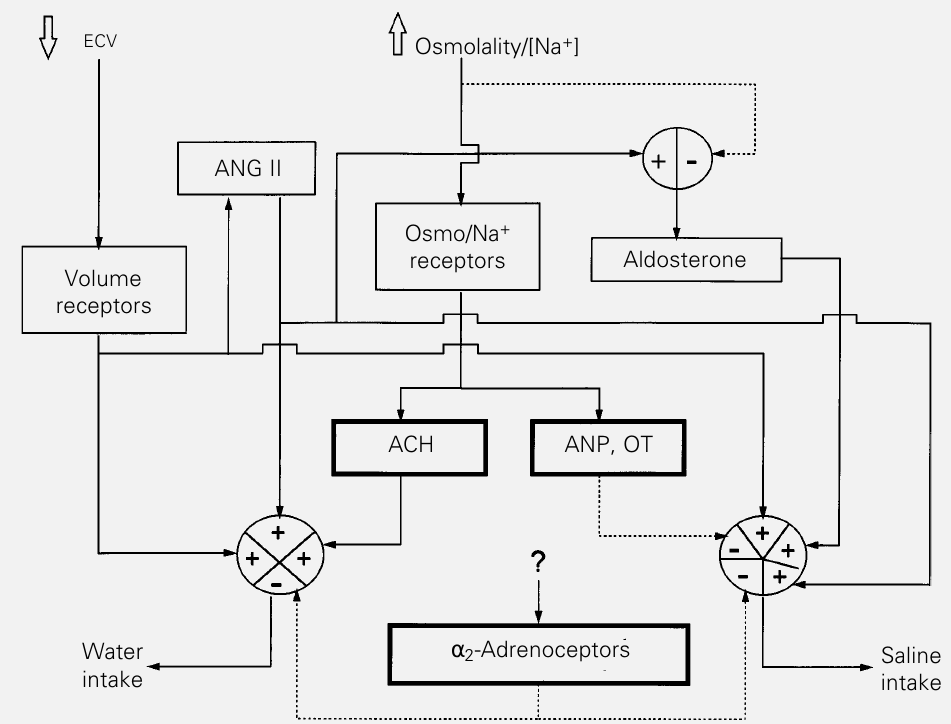
Figure 1 - Multifactorial block- diagram model of the control of water and saline intake. Central circuits that control water and saline intake and integrate the multiple inhibiting and activat- ing factors described in the lit- erature are represented by sum- ming points (see text for refer- ences and discussion). Bold lines indicate central factors. Dotted lines indicate inhibiting and continuous lines indicate activating factors. Indents indi- cate bypass points. ECV, Extra- cellular volume; ACH, acetylcho- line; ANP, atrial natriuretic pep- tide; OT, oxytocin; ANG II, an- giotensin II (either central or pe-